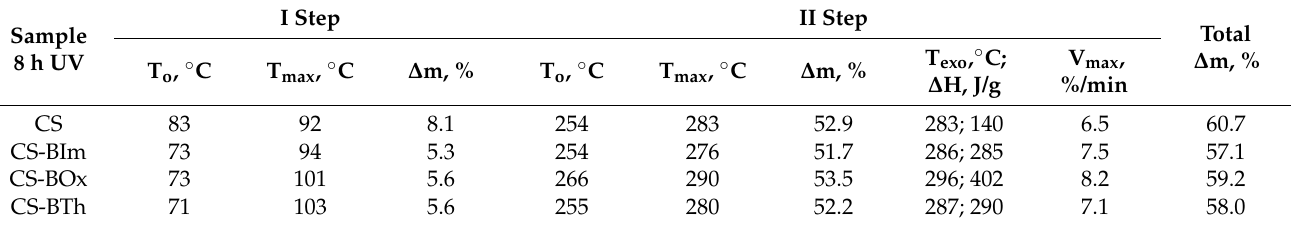
Table 3. Thermal parameters of 8 h UV irradiated chitosan and modified chitosan samples determined from TGA